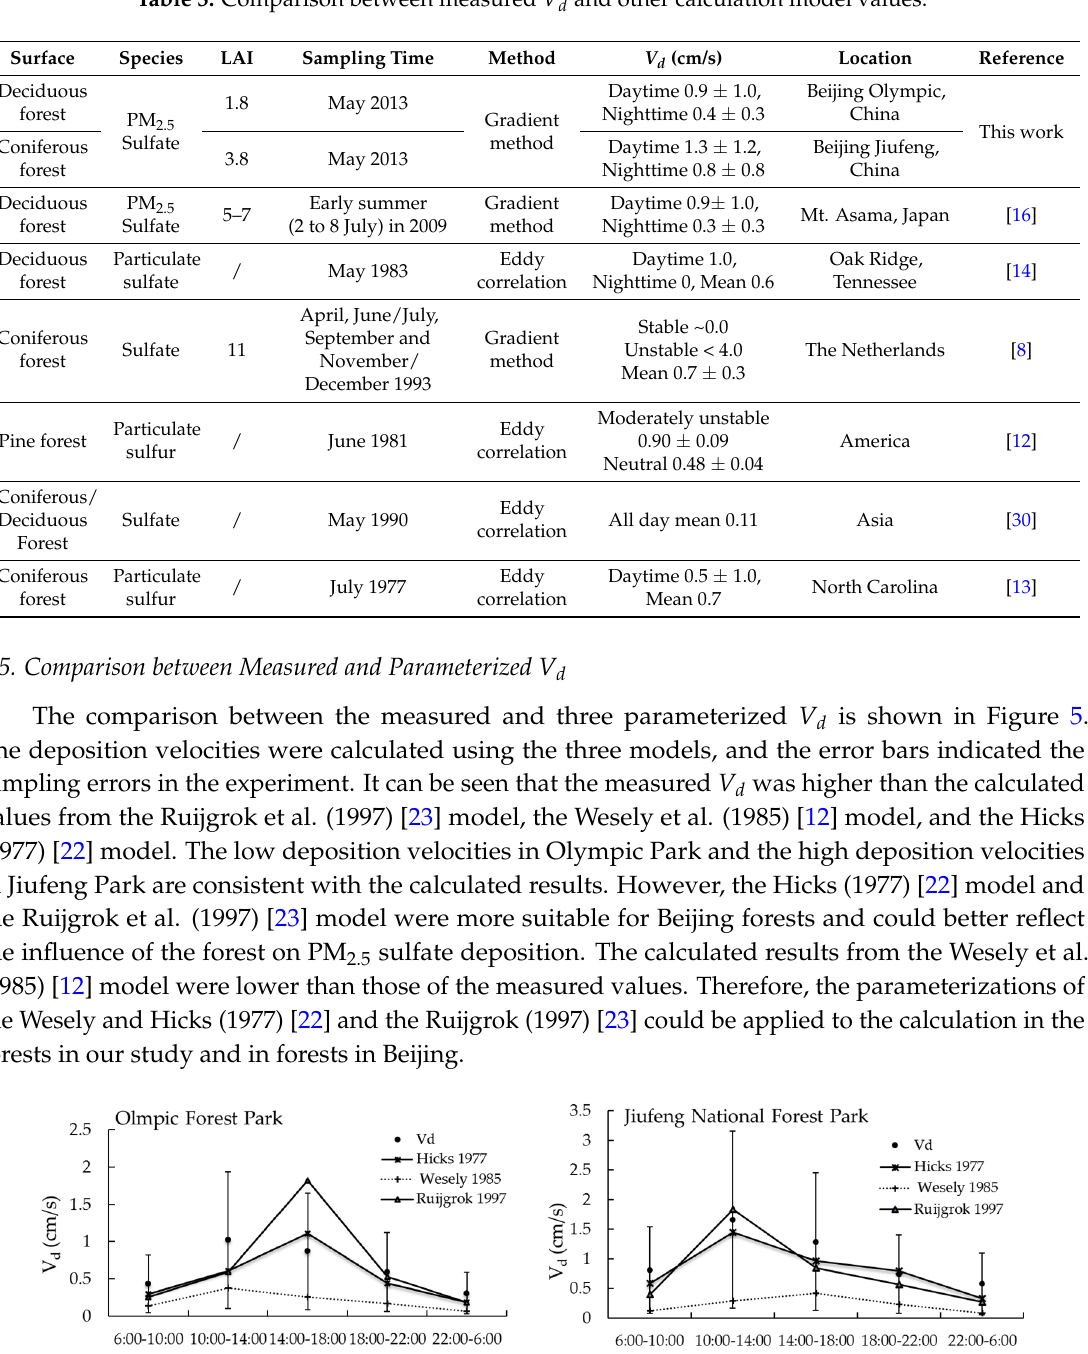
Table 3. Comparison between measured V d and other calculation model values.